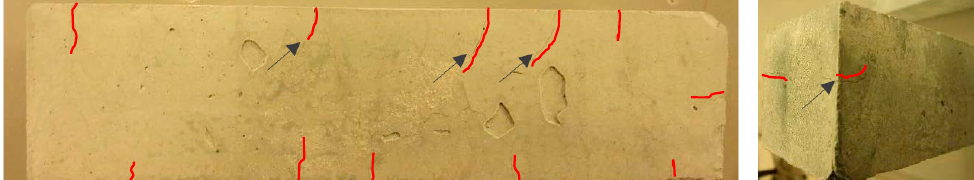
Figure 15. Flexural strength development for pastes with l/b = 0.5.